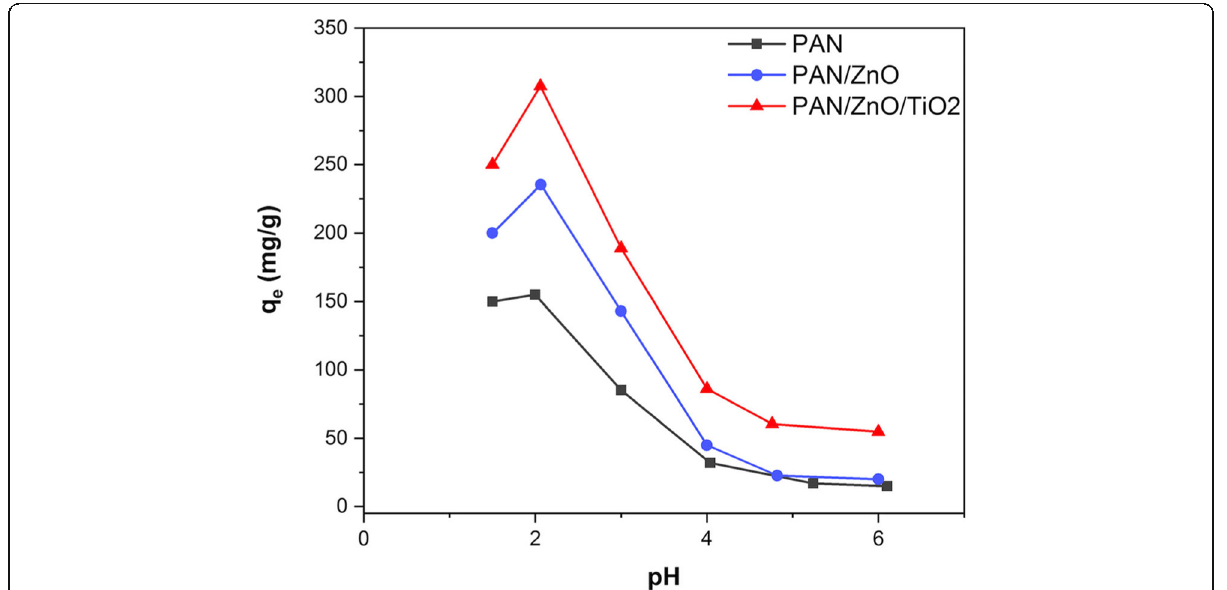
Fig. 6 The effect of pH on the adsorption of Cr (VI) using PAN based n- fib@Mats (pH = 1 –